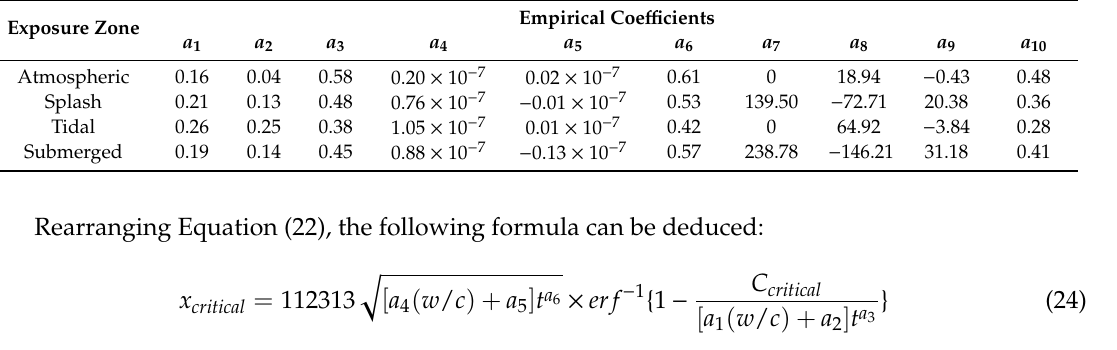
Table 1. Empirical coe ffi cient for di ff erent exposure